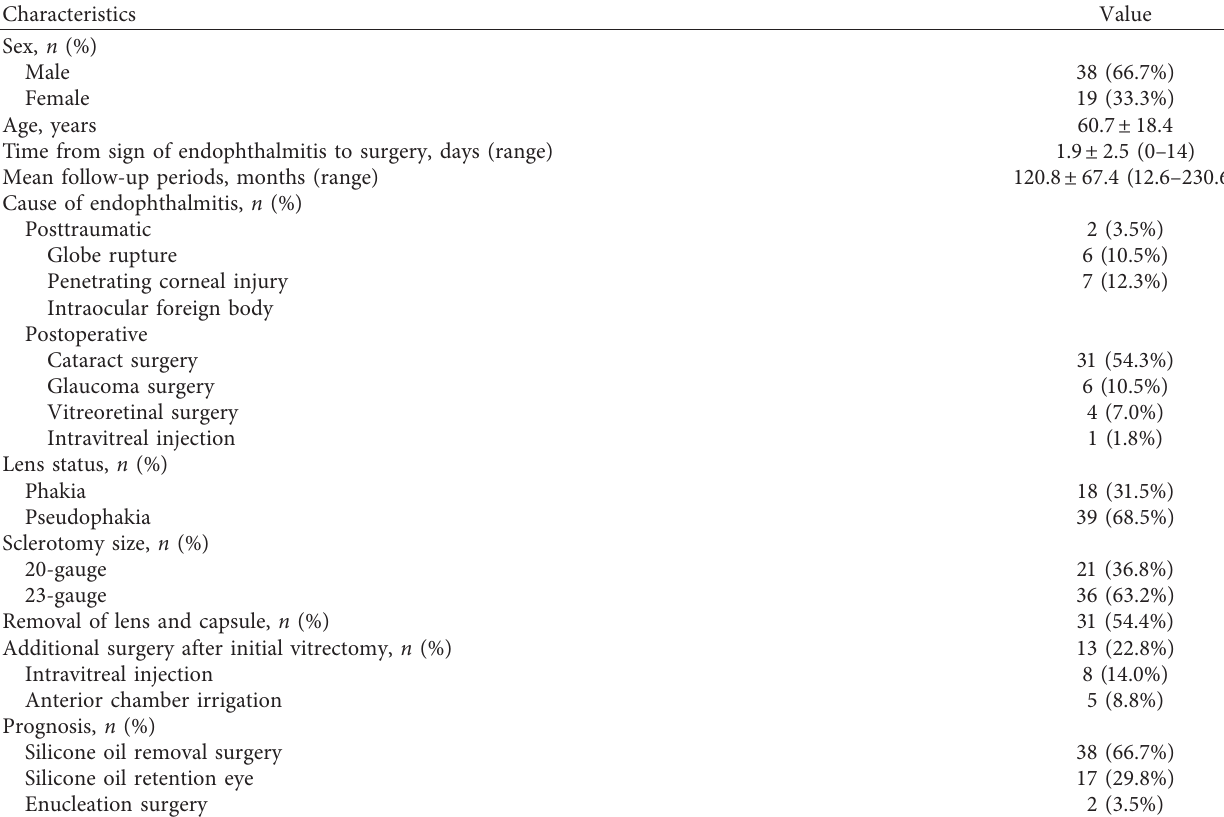
Table 1: Clinical characteristics of cases with exogenous endophthalmitis.